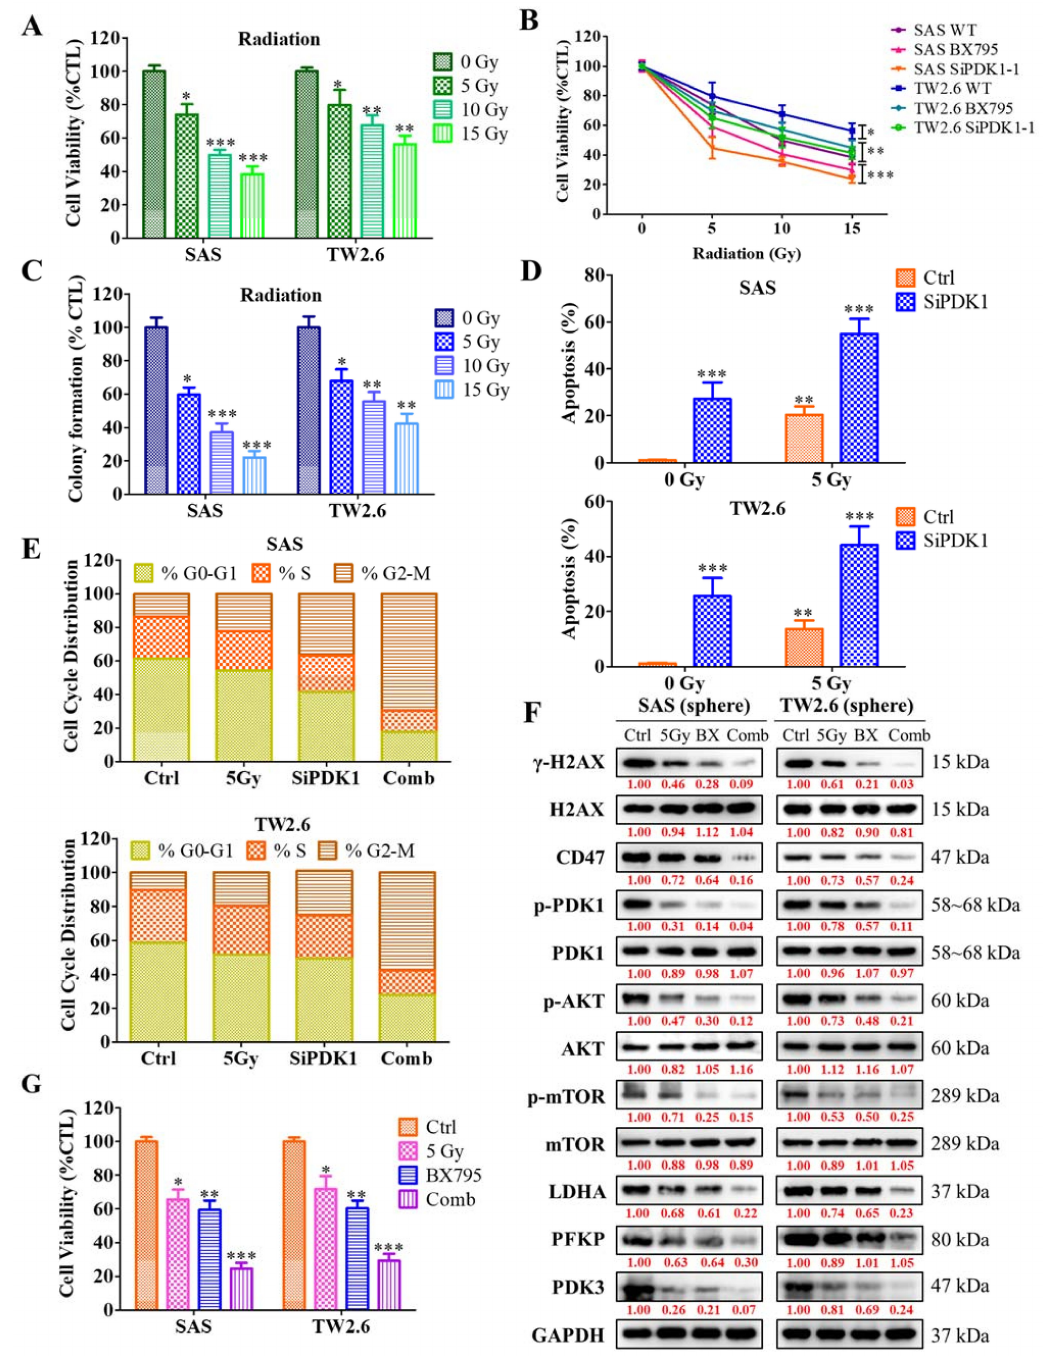
Figure 6. Suppression of PDK1 expression induces the sensitivity of OSCC cells toward radiotherapy. ( A ) Representative bar plot showing the inhibitory effect of radiotherapy (0 Gy-15 Gy) on the cell viability of SAS and TW2.6 OSCC cells. ( B ) The survival curve represented the radiosensitivity of PDK1 depleted (siPDK1-1, -2) and control (Wild type) SAS and TW2.6 OSCC cells. ( C ) The colony-forming assay was conducted for PDK1 knockdown and control OSCC cells with indicated IR dose. ( D ) Flow cytometry analysis was used to detect the apoptosis of PDK1 depleted SAS and TW2.6 OSCC cells with or without radiation (0 Gy-5 Gy). ( E ) The cell cycle analysis (G2/M) was evaluated by flow cytometry with or without 5 Gy radiation on PDK1 knockdown SAS and TW2.6 OSCC cells. ( F ) The inhibitory effect of 5 Gy, BX (BX795) or combination on the expression of the protein level expression of γ H2AX, CD47, PDK1, Akt, mTOR, LDHA, PFKP, PDK3 in SAS and TW2.6 cells, as demonstrated by western blot analyses. GAPDH served as the internal control. ( G ) Effect of aforementioned treatment on the Orosphere generation ability of SAS and TW2.6 cell lines. * p < 0.05, ** p < 0.01, *** p <